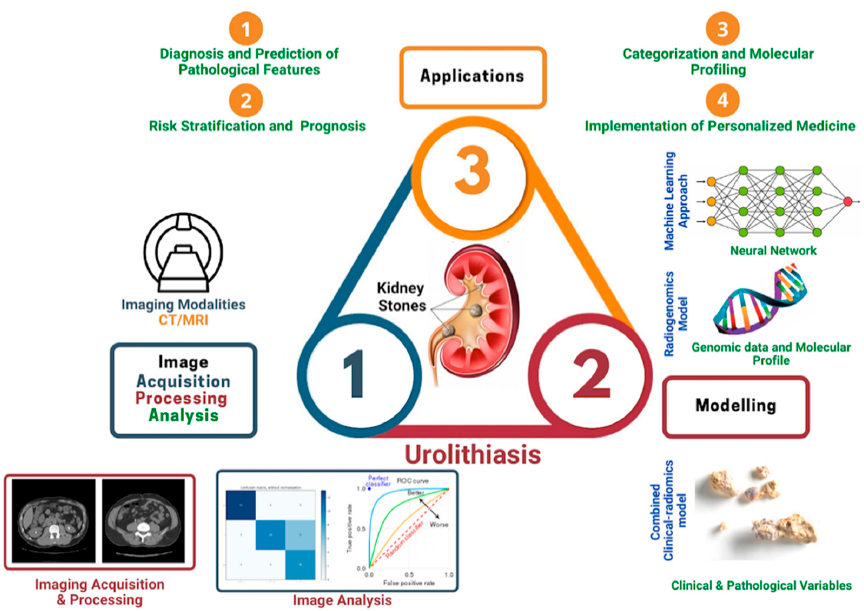
Figure 1. Potential contributions of radiomics and radiogenomics to the management of a patient with urolithiasis.